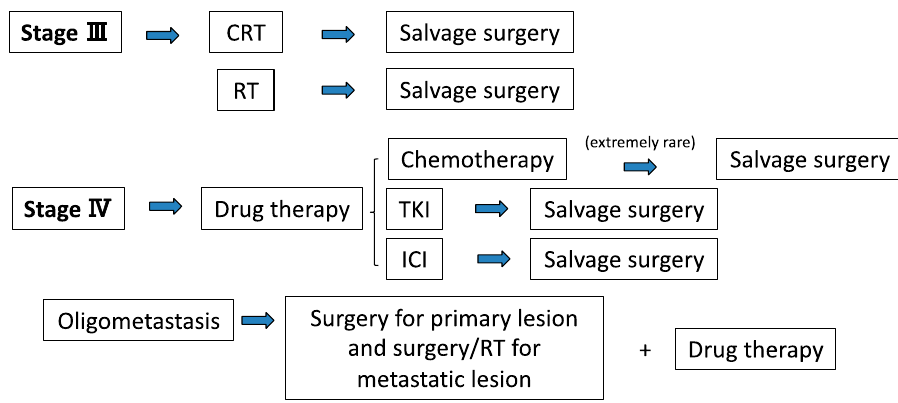
Figure 1. Current treatment strategies with surgery for unresectable stage III / IV NSCLC. CRT: chemoradiotherapy, ICI: immune-checkpoint inhibitor, NSCLC: non-small cell lung cancer, RT: radiotherapy, TKI: tyrosine kinase inhibitor.